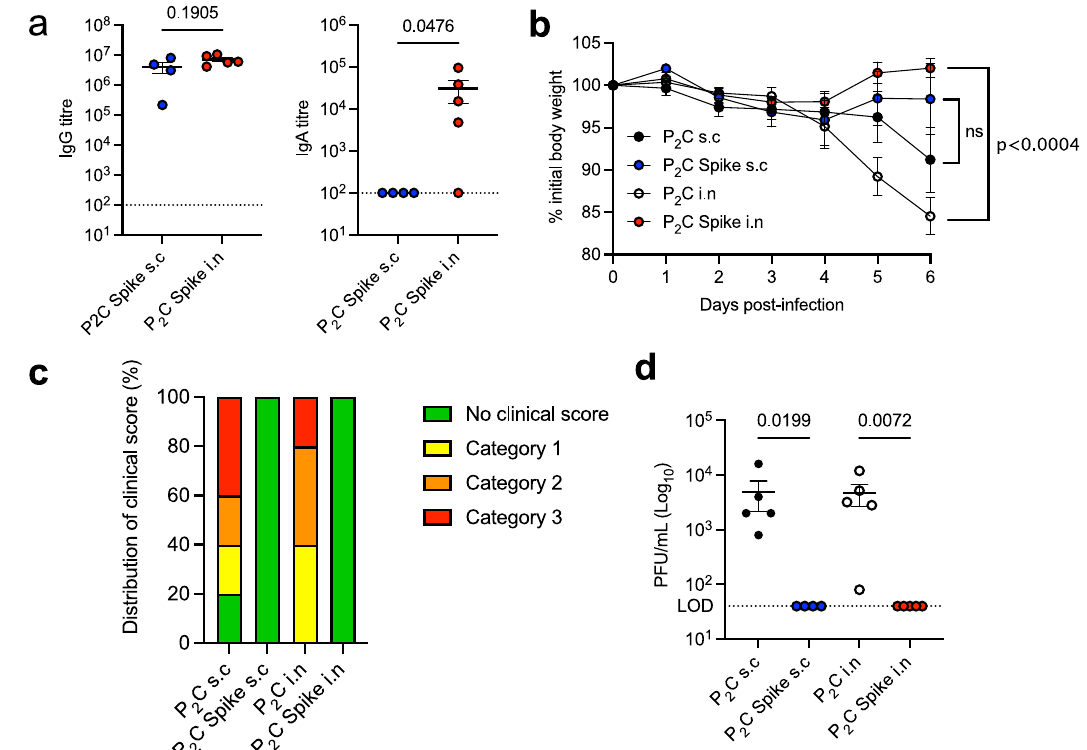
Fig. 10 | Vaccination with Pam 2 Cys Spike induces potent sustained protection against SARS-CoV-2 challenge. K18-hACE2 mice ( n =5) were immunized with Pam 2 Cys alone (P 2 C; black), or Pam 2 Cys Spike, sub-cutaneously (s.c; blue) or intra- nasally (i.n; red) three times, 2.5 weeks apart. 6 weeks post fi nal vaccination mice were challenged with SARS-CoV-2 i.n. a Anti-spike IgG and IgA titres in serum collected 5 weeks post fi nal vaccination, as determined by ELISA. b Mouse weight loss from days 0 – 6 post infection (p.i) with SARS-CoV-2. c Clinical score